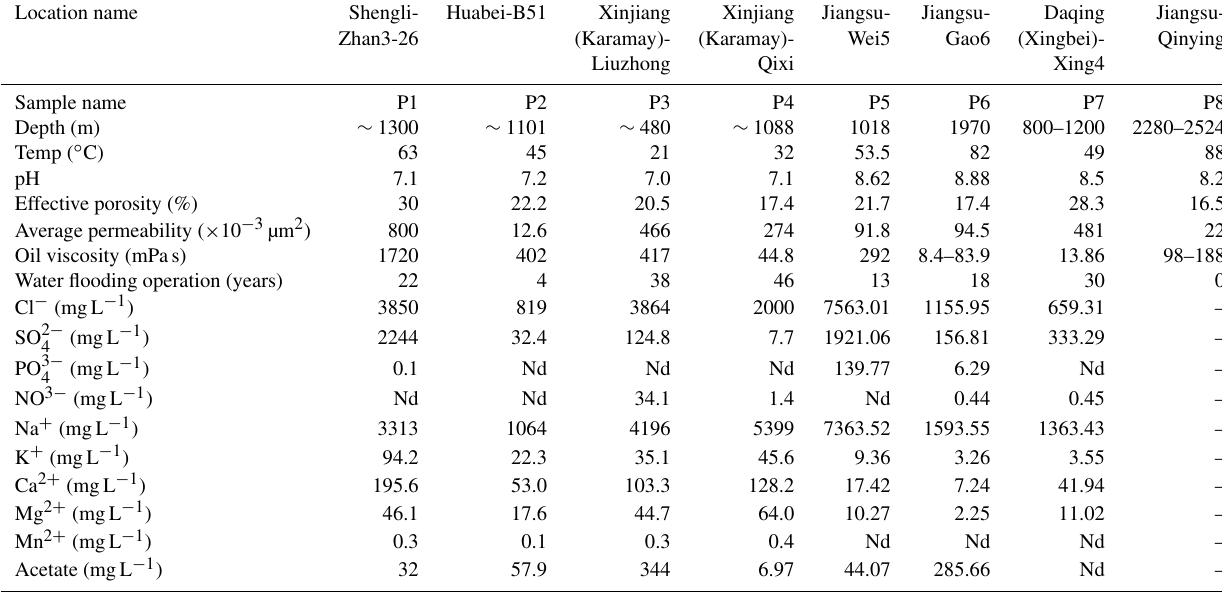
Table 1. Reservoir geophysical properties and physicochemical properties of aqueous-phase